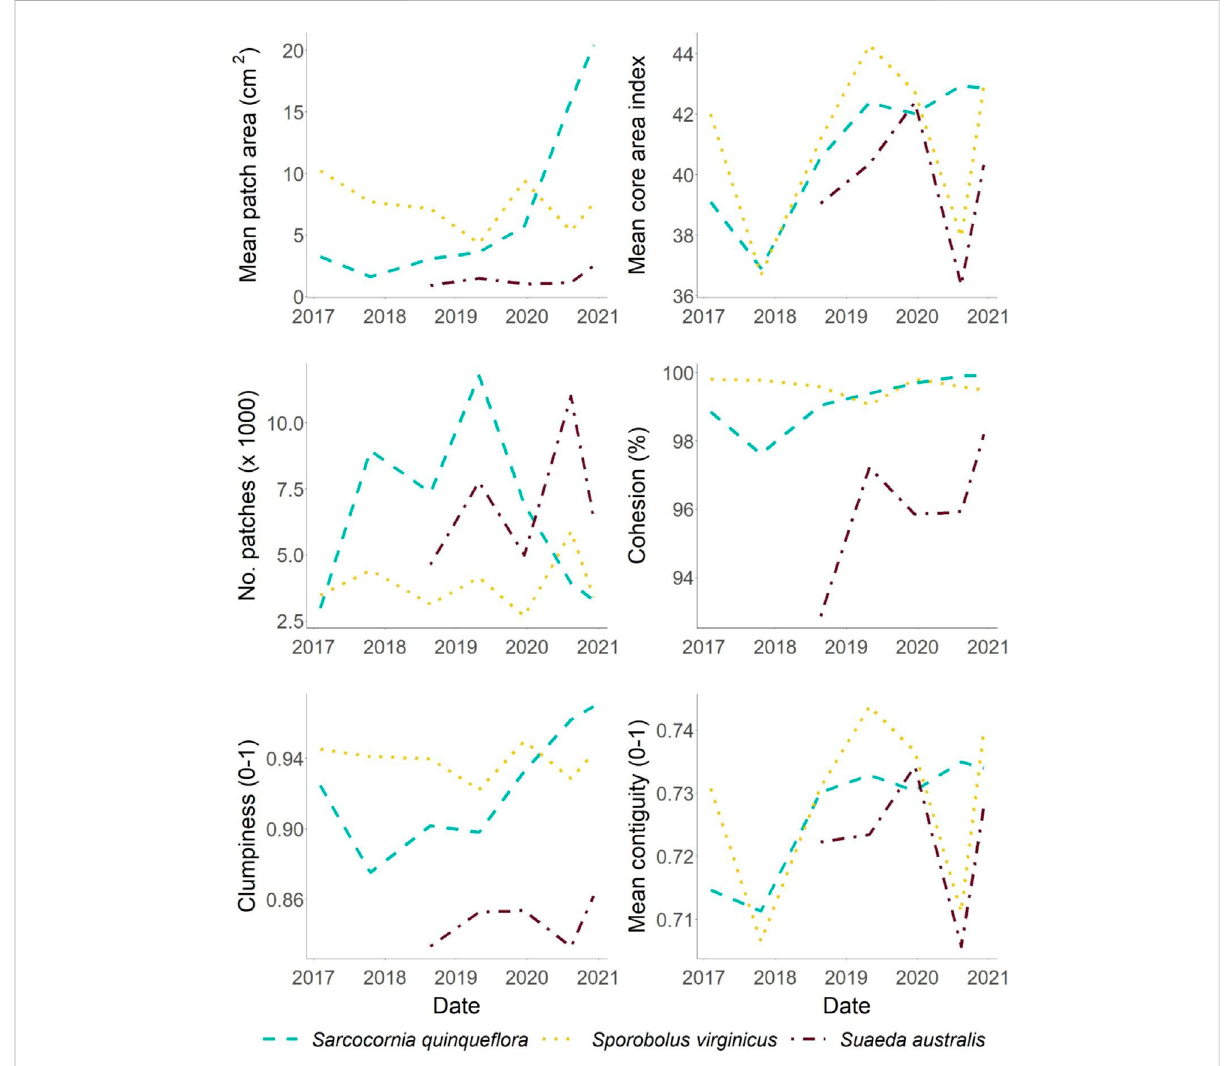
FIGURE 5 Class-level patch metrics: mean patch area, mean core area index (percentage of each patch that is non-edge cells), number of patches, cohesion (connectedness of patches of the same class), clumpiness (proportion of adjacent patches that are the same class) and mean contiguity (connectednessofcellswithinpatches)forthreesaltmarshclasses( Sporobolusvirginicus,Sarcocorniaquinque fl ora and Suaedaaustralis ).Thereare missing data for Suaeda australis because it was not classi fi ed in the fi rst two